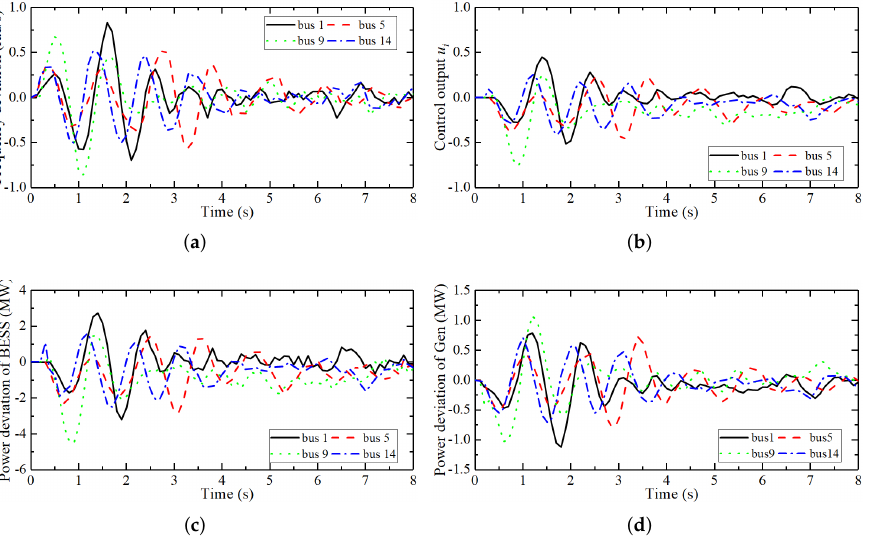
Figure 11. Frequency deviation, control output, BESS and power output deviation of the generator in IEEE14 bus testing system, η ji = 0.6. ( a ) Frequency deviation. ( b ) Control output u i . ( c ) Power deviation of BESS. ( d ) Power deviation of generators.